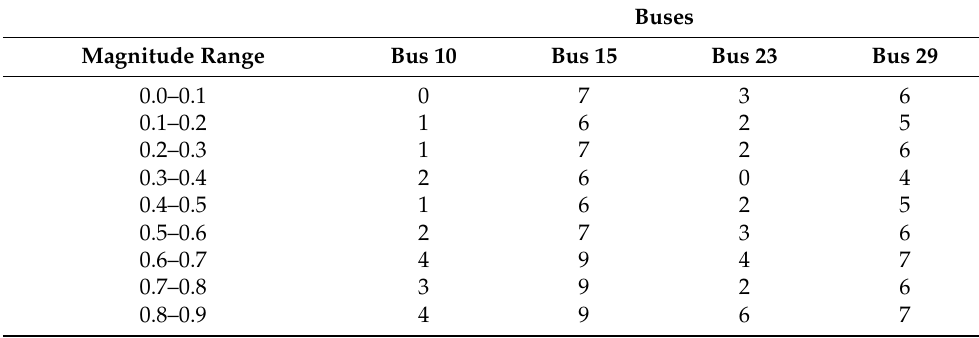
Table 6. Frequency of sag versus magnitude in some observed buses.